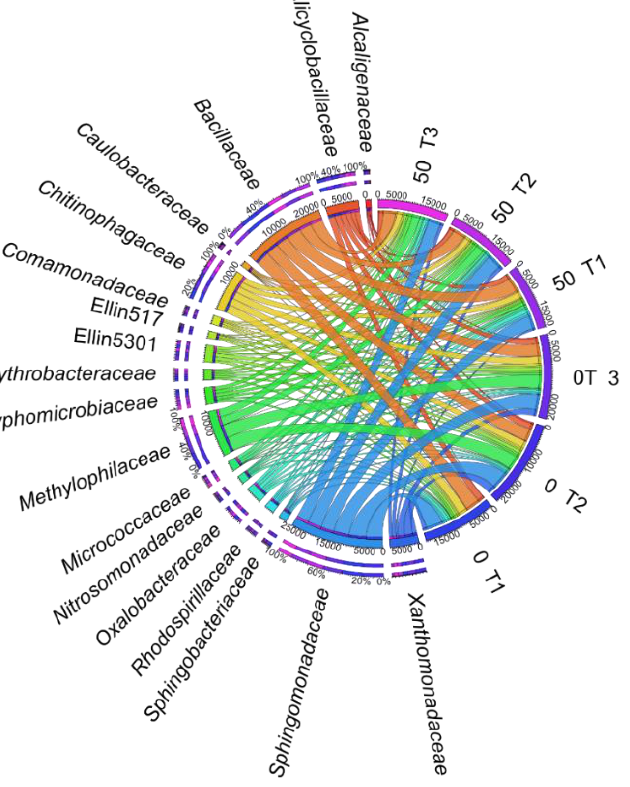
Figure 9. The relative abundance of dominant family of bacteria in soil with a difference between proportions ≥1%. 0; 50—doses of o -cresol (mg kg −1 DM of soil); T1—15 th day, T2—30 th day, T3—45 th day of research.